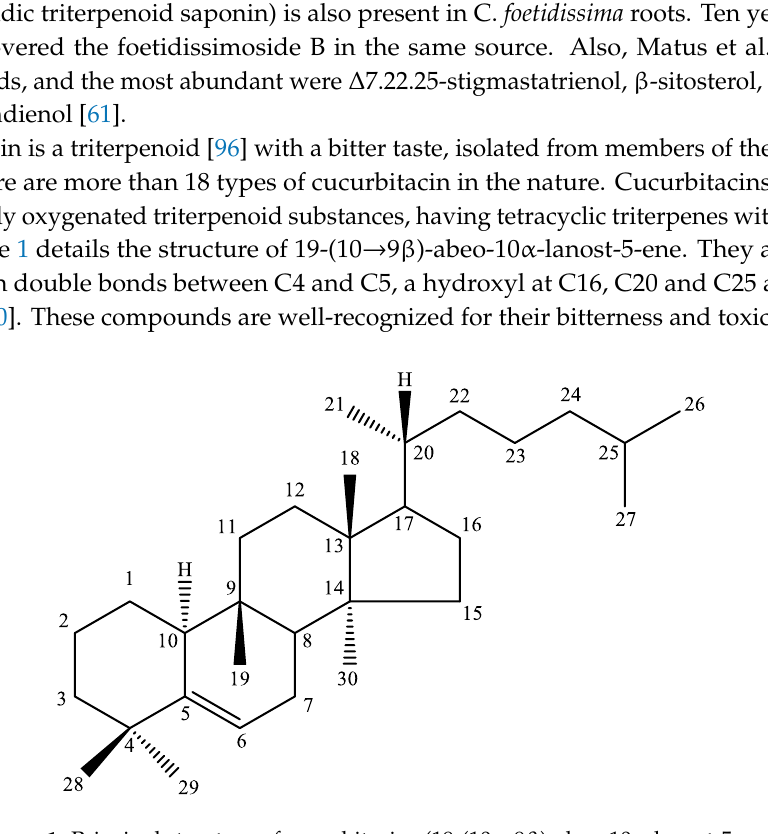
Figure 1. Principal structure of cucurbitacins (19-(10 → 9 β )-abeo-10 α -lanost-5-ene).